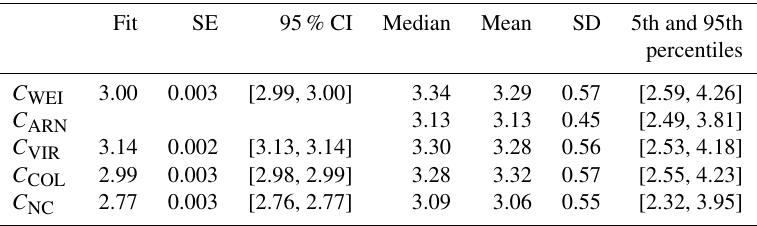
Table 2. Average values for the multiple-scattering correction factor ( C ref ) for the different correction algorithms. The values are reported at 637nm. The slope of the fit, standard error of the fit (SE), and 95% confidence interval (CI) were determined by a linear regression applied to the whole data set. The median, mean, and standard deviation (SD), as well as the 5th and 95th percentile range, were determined from the C ref values that were calculated for each data point separately.